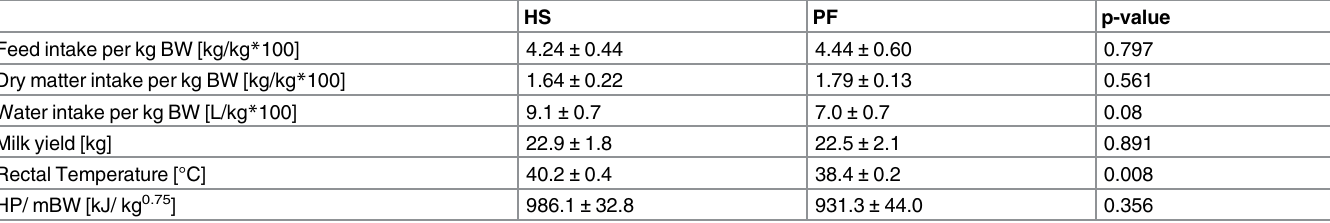
Table 1. Animal data of heat-stressed (HS) and pair-fed (PF) cows determined in the respiration chamber.